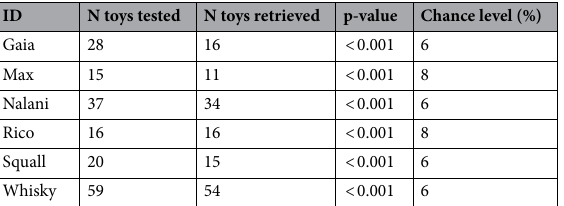
Table 1. Results of the Baseline test with all the toys of each WK dog. Each dog is tested on his ability to recognize all toys reportedly known by name. One trial per toy is carried